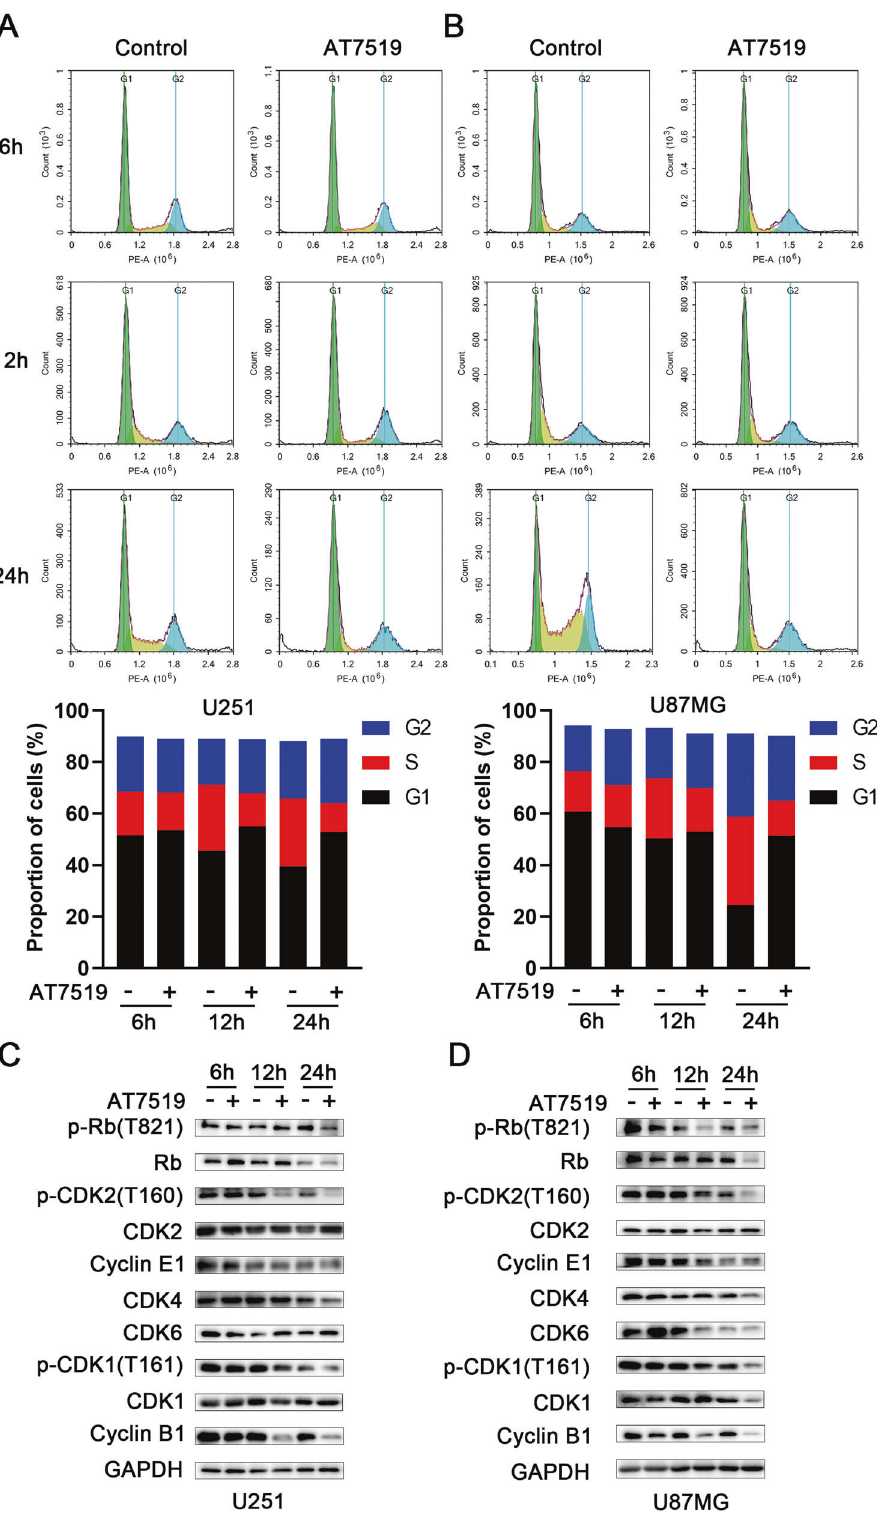
Fig. 3 AT7519 arrests glioblastoma cells at the G1/S and G2/M phases of the cell cycle. A , B After U87MG and U251 cells were treated with different concentrations of AT7519 for 48 h, the cell cycle distribution was detected by fl ow cytometry. C , D Western blot analysis of cell lysates treated with different concentrations of AT7519 for 48 h. Detection of G1/S and G2/M arrest-related